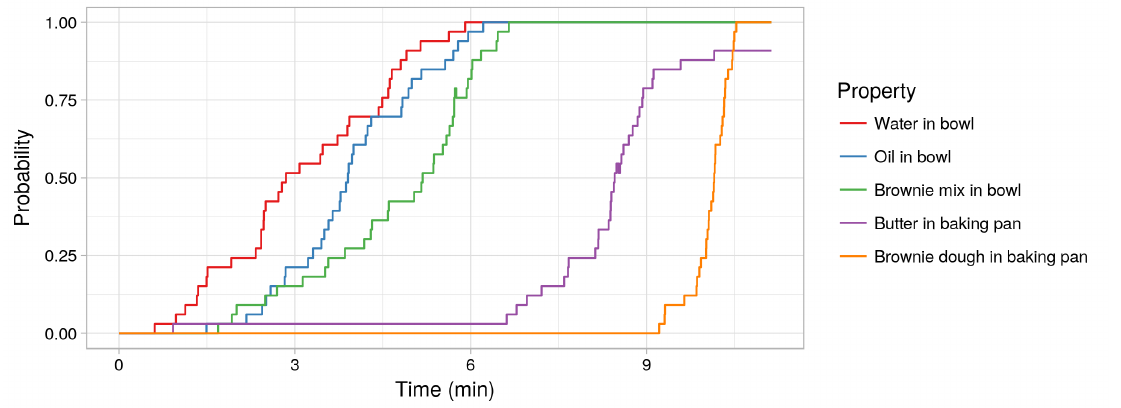
Figure 9. Example of a reasoning about the executed sequence. The probability of